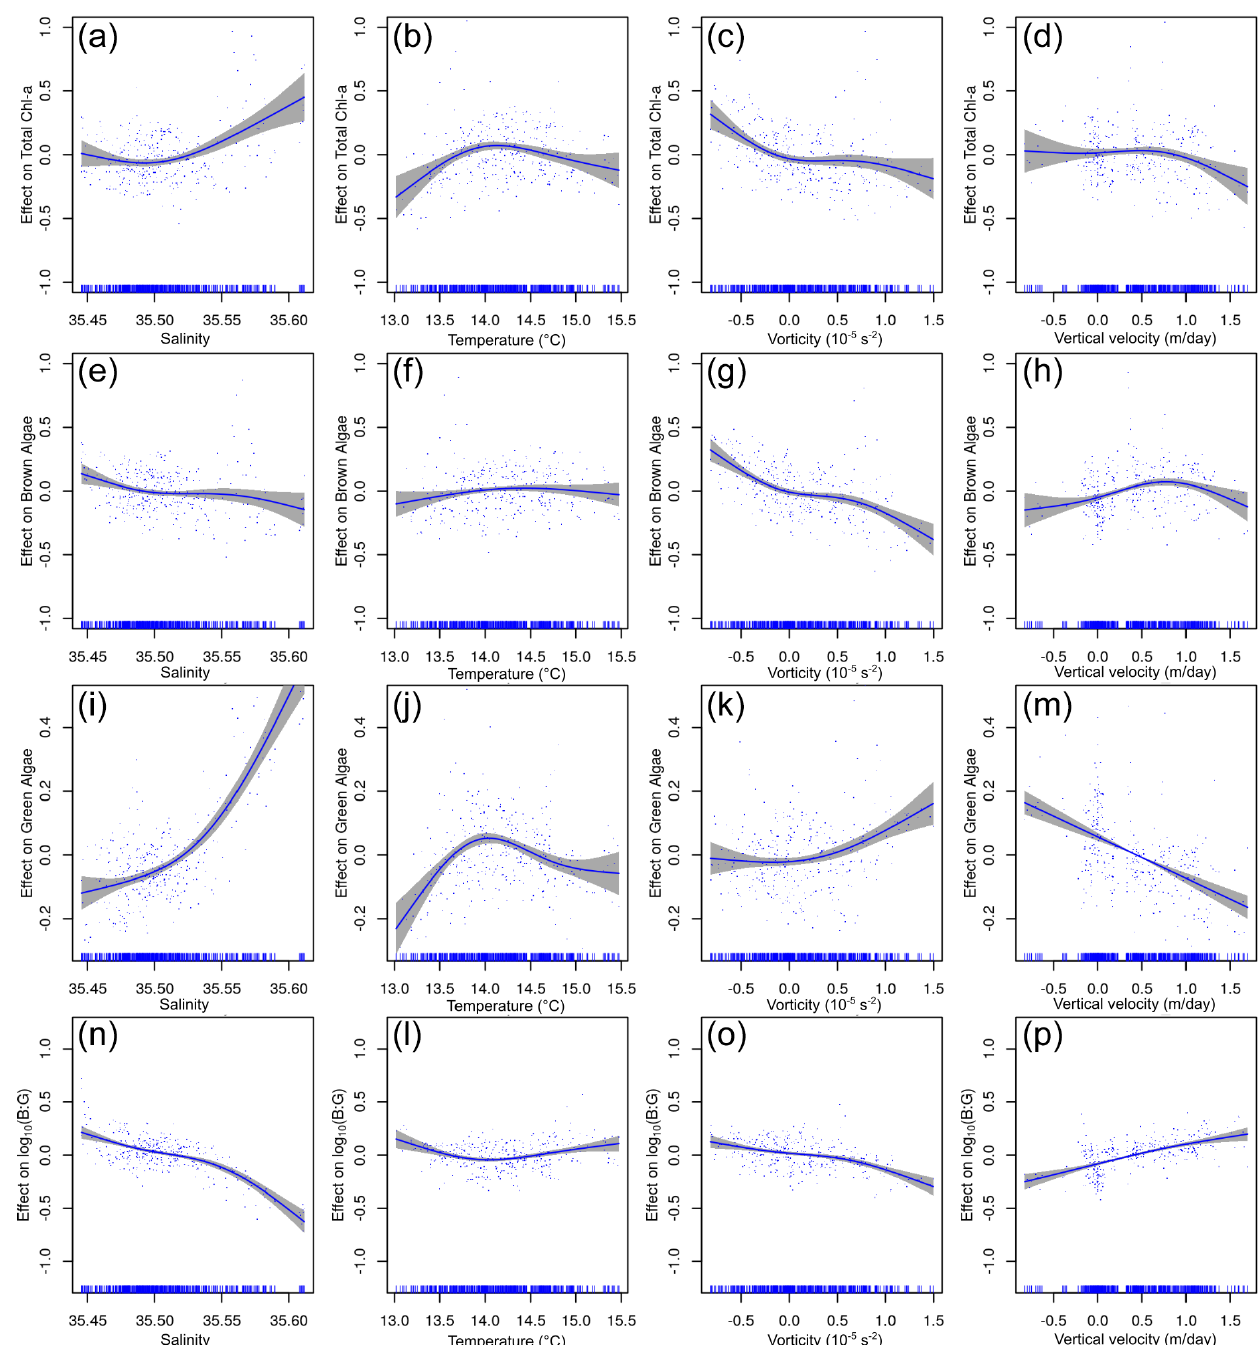
Figure 10. Relationship between environmental variables and chl a from the deep chlorophyll maximum (DCM) subset GAMs. The y axis indicates the additive effect that the term on the x axis has on the chl a . The following variables are shown (from top to bottom): total chl a , brown chl a , green chl a , and the brown : green (B : G) ratio. The shaded area represents the confidence interval of